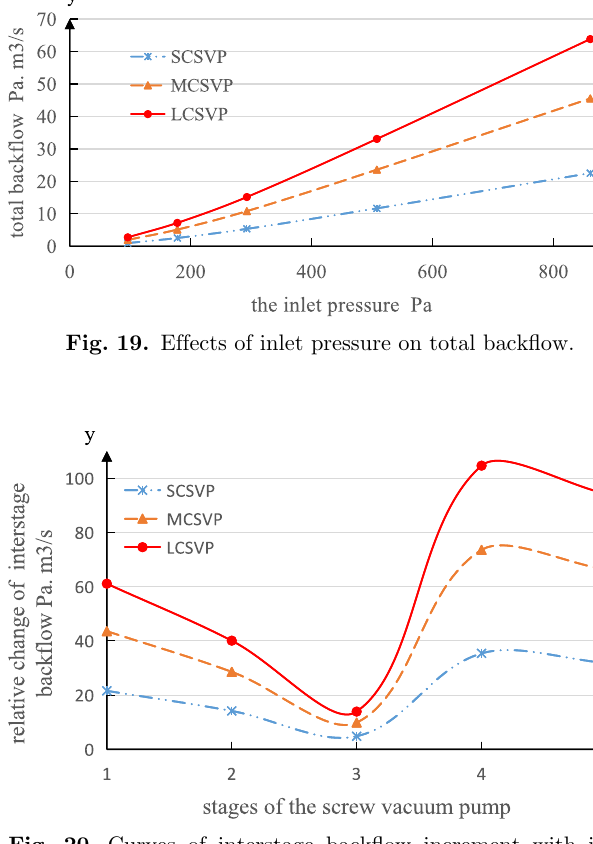
Fig. 20. Curves of interstage back fl ow increment with inlet